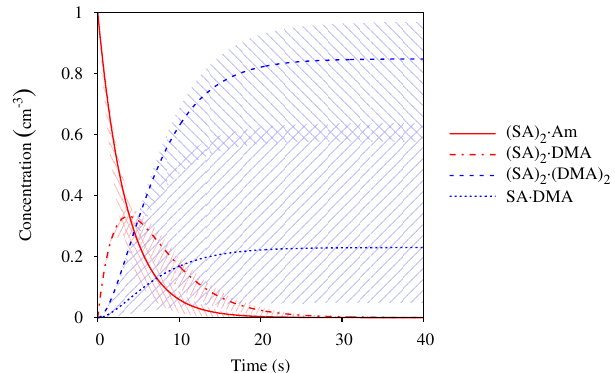
Fig. 4. Reaction of ( SA ) 2 · Am clusters with DMA gas at a pres- sure of 1 . 2 × 10 − 8 Torr. The sensitivity of the dynamics to cluster formation energies is seen by lowering the Gibbs free energy of one species at a time by 1 kcalmol − 1 and rerunning the simulation (shaded